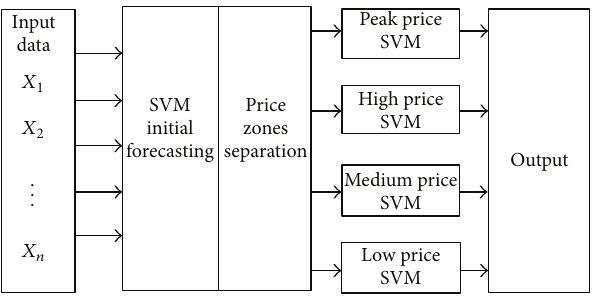
Figure 2: Two-stage multiple SVM forecasting model